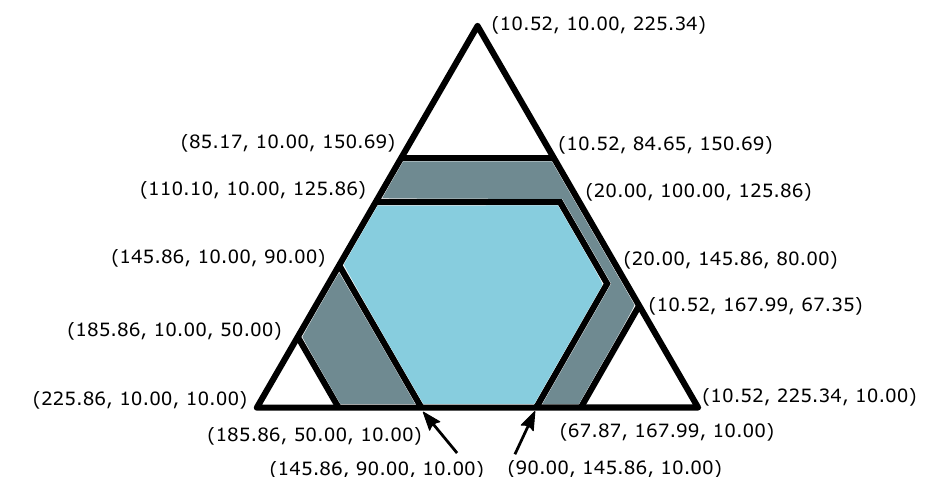
Figure 5. The core ¯ C ( ω 2 ) (gray region) and approximated core ¯ D ( ω 2 ) (blue region inside gray region) in stochastic game with ω 2 initial